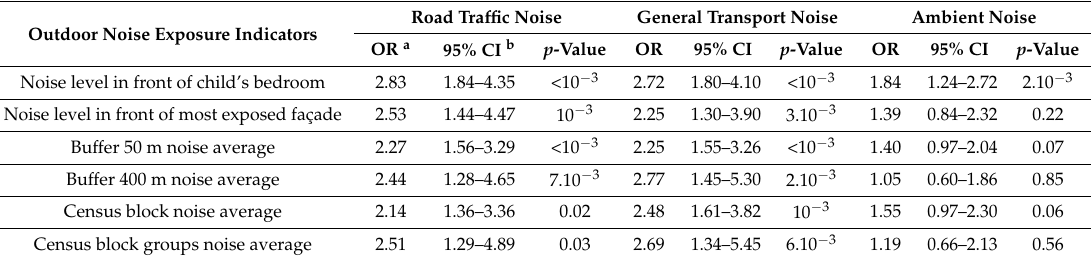
Table 3. Associations between annoyance related to road traffic noise, general transportation noise or ambient noise and the outdoor noise exposure indicators in children: bivariate analysis.